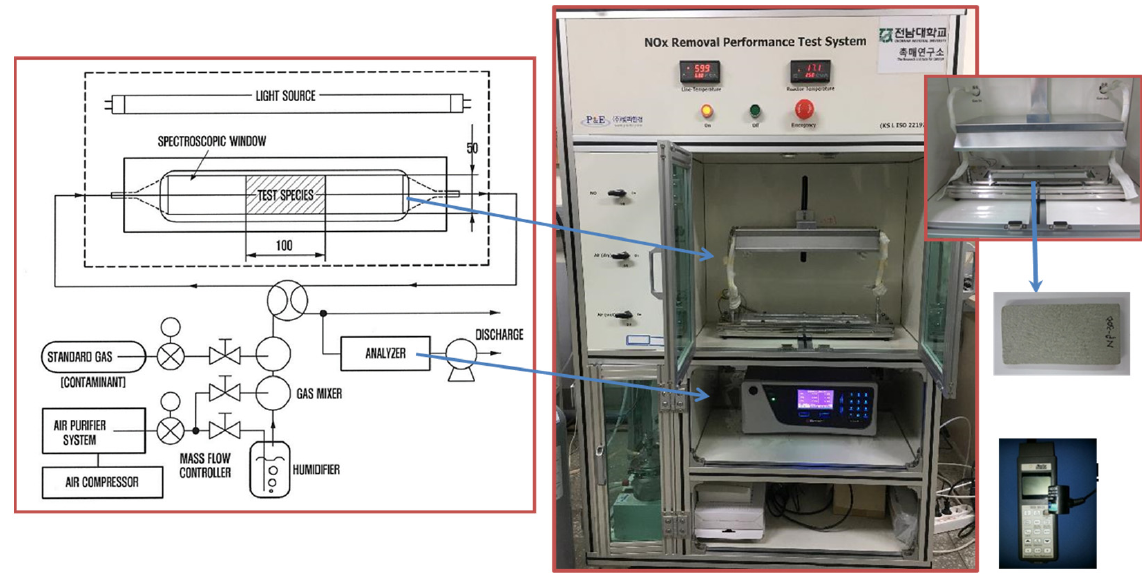
Figure 2. Apparatus used to measure NO removal as per ISO 22197-1 specifications. Table 3. Photoreactor test results for NO removal rate at the preliminary